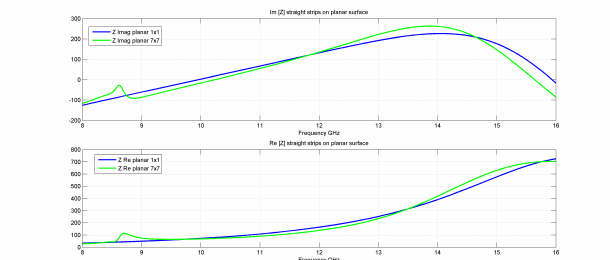
Fig. 3. Imaginary part (top panel) and real part (bottom panel) of Z A of the isolated wire (blue line) and the wire surrounded by identical passive ones (green line)